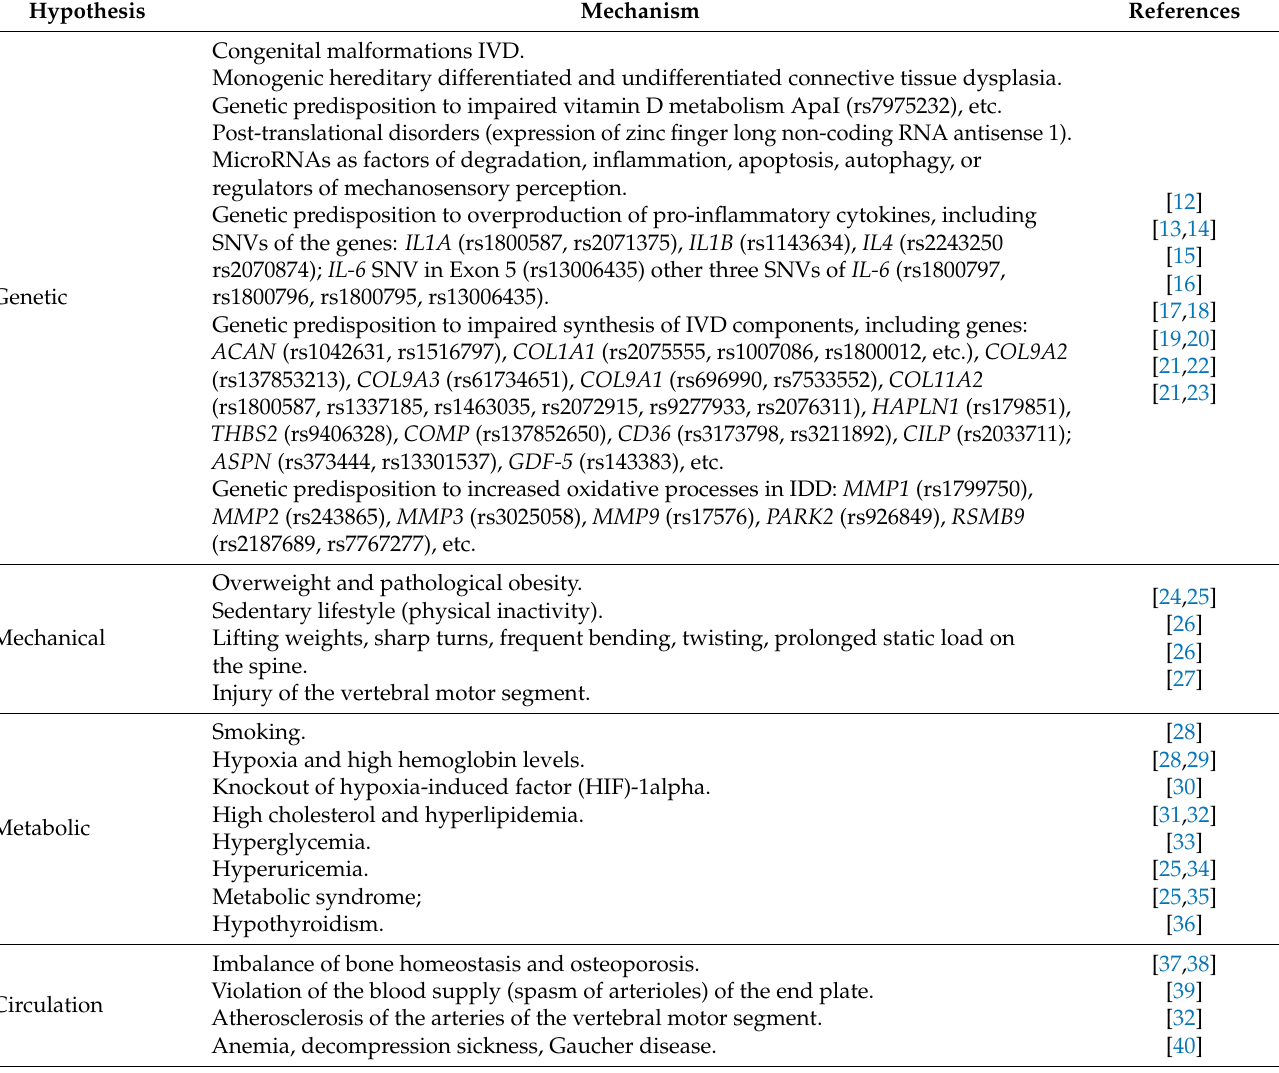
Table 1. Hypotheses of intervertebral disc